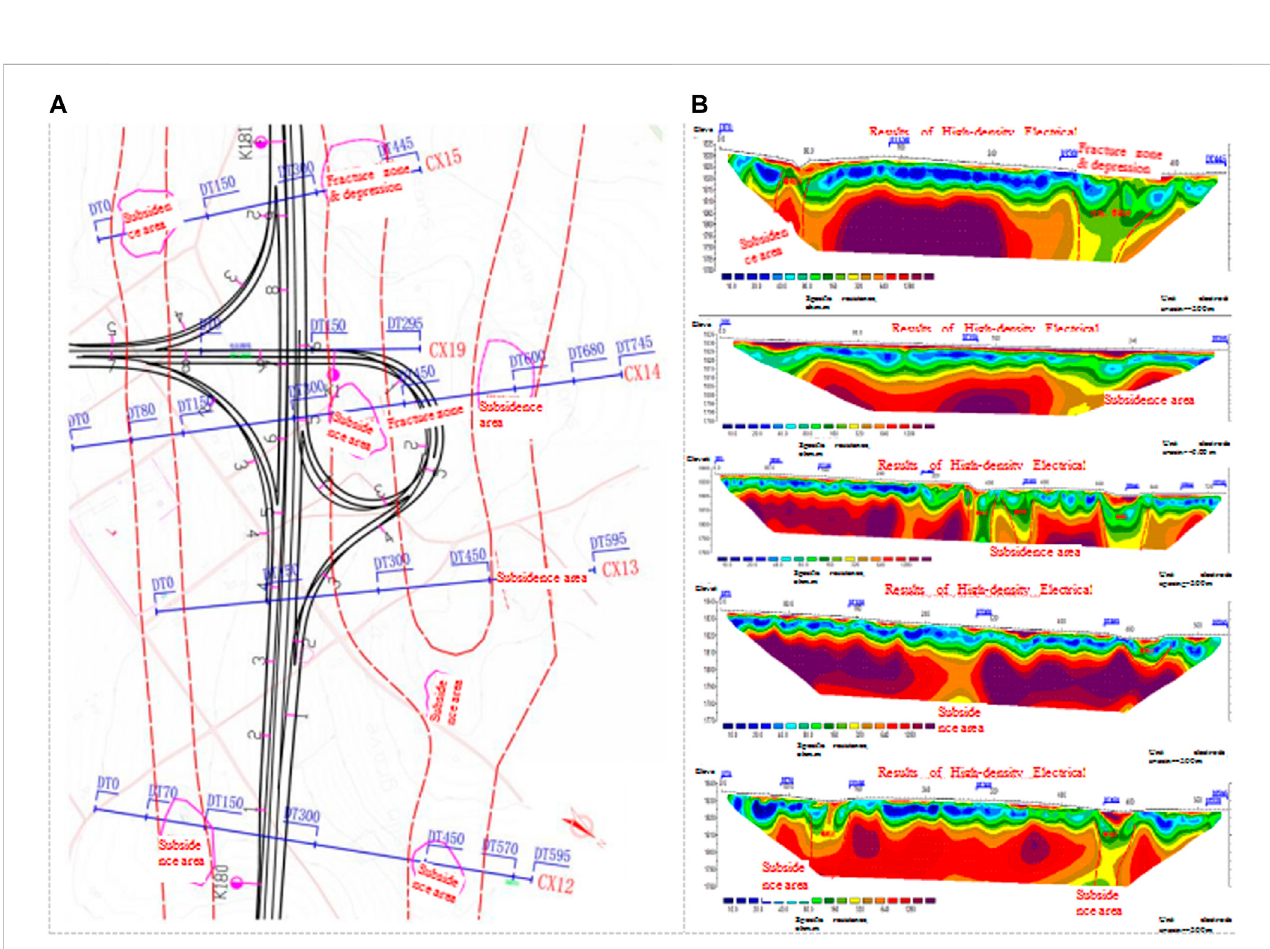
FIGURE 6 Comprehensive geophysical prospecting result map of the K179+400~K181+466 interchange area.